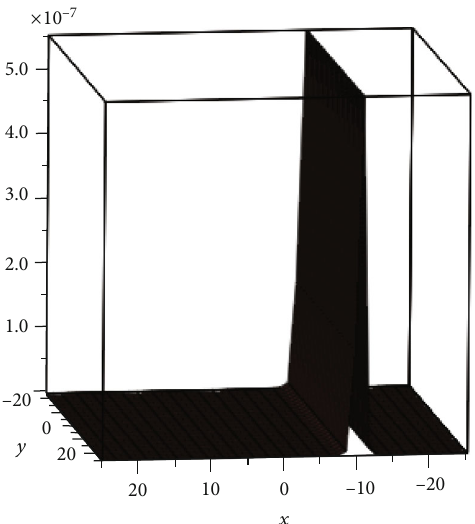
Figure 11: Graphical view of the absolute error for K ð ζ , ρ Þ of system 2 .